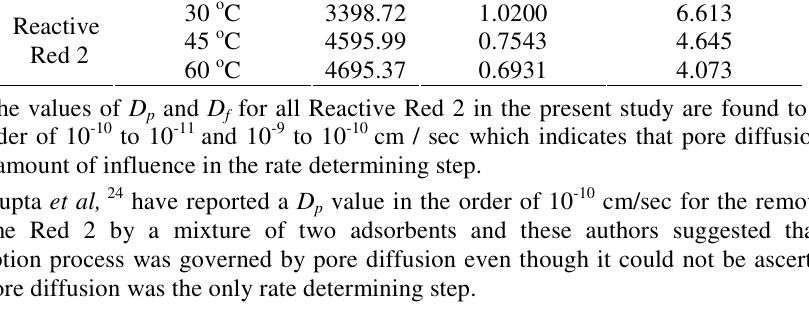
values for the chosen adsorbent - adsorbate system